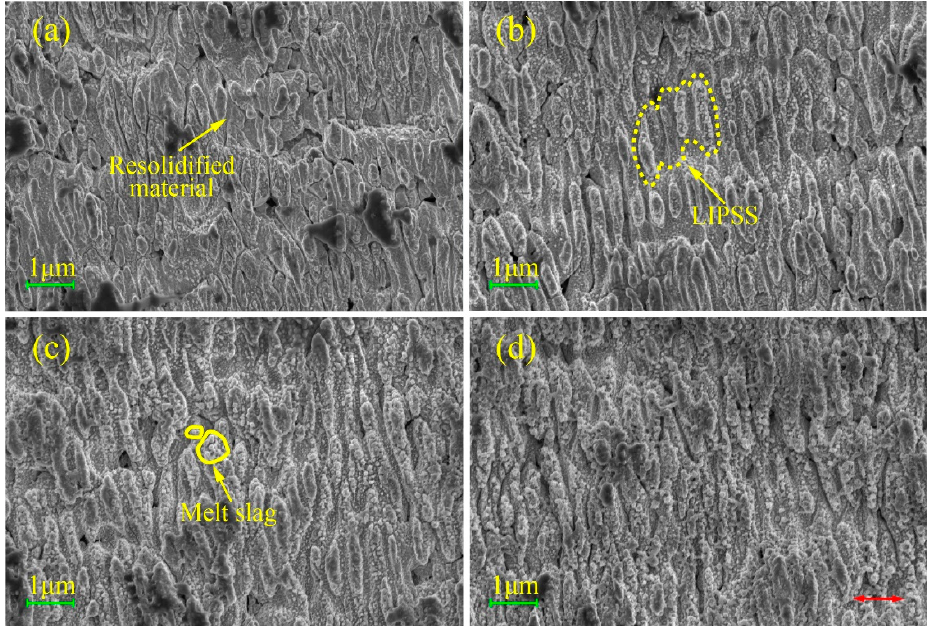
Figure 5. SEM photographs of fs laser-irradiated regions under different single pulse energies. ( a ) 50 μ J, ( b ) 70 μ J, ( c ) 80 μ J, and ( d ) 100 μ J. The red arrow indicates the direction of laser polarization.